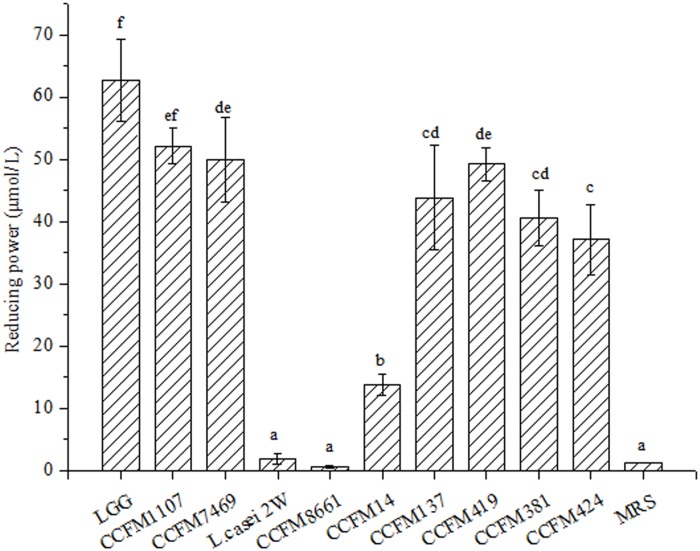
RP values of the CFSs (mean ± SD, n = 3).MRS control sample without lactobacilli. RP values are expressed as μM of cysteine. Different letters indicate statistically significant differences at p < 0.05. Bars with no common letters are significantly different (p < 0.05).